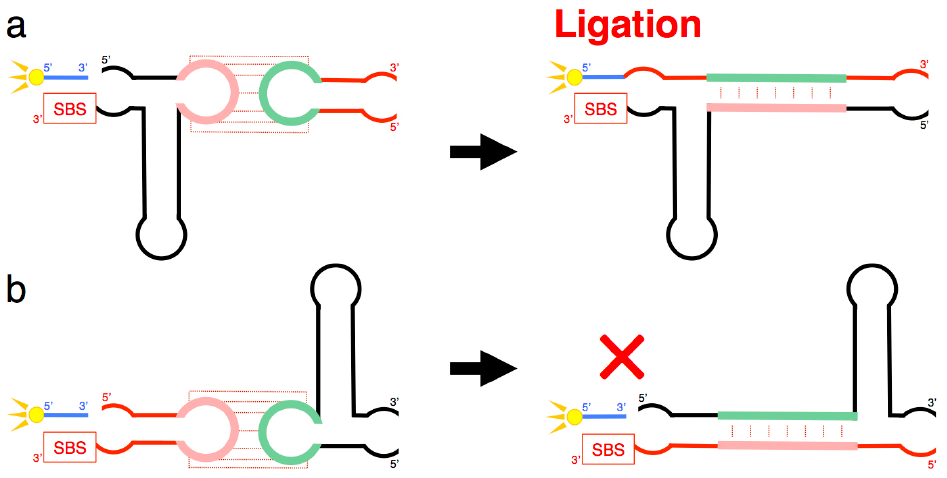
Figure 8. ( a ) Schematic representation of a process that may occur when <A> and <hairpin- ∆ U> combine. Although <A> contains the SBS, substrate ligation occurred on <hairpin- ∆ U> despite the absence of SBS in this molecule (Figure 6). ( b ) Schematic representation of a process that may occur when < ∆ U> and <hairpin-A> combine. Any large substrate ligation products were not detected in this combination, although <hairpin-A> contained the SBS (Figure 6). Both ( a , b ) suggest complex tertiary interactions between the two ribozymes, including kissing-loop interaction-induced annealing and the formation of a stable duplex, which partially rescued the activity of the truncated ribozyme.